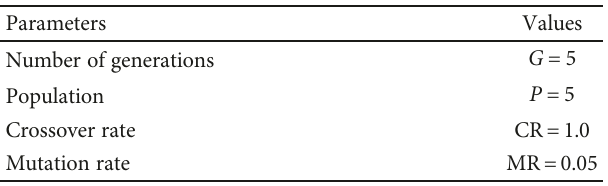
Figure 7: Power curve of the optimized solar cell. Table 3: GA simulation parameters.